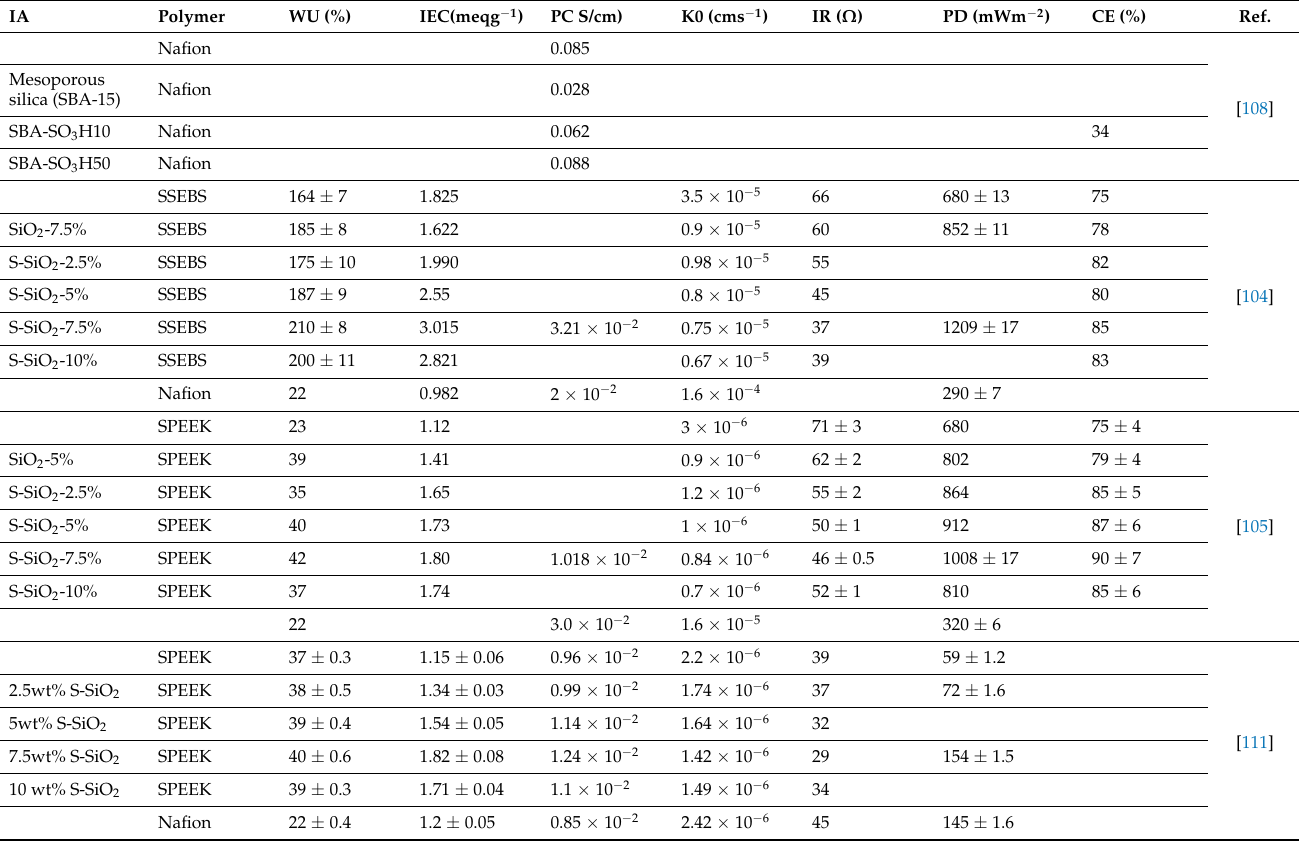
Table 1. Physicochemical properties and performance evaluation results of sulfonated silica incorpo- rated polymer membrane for MFC